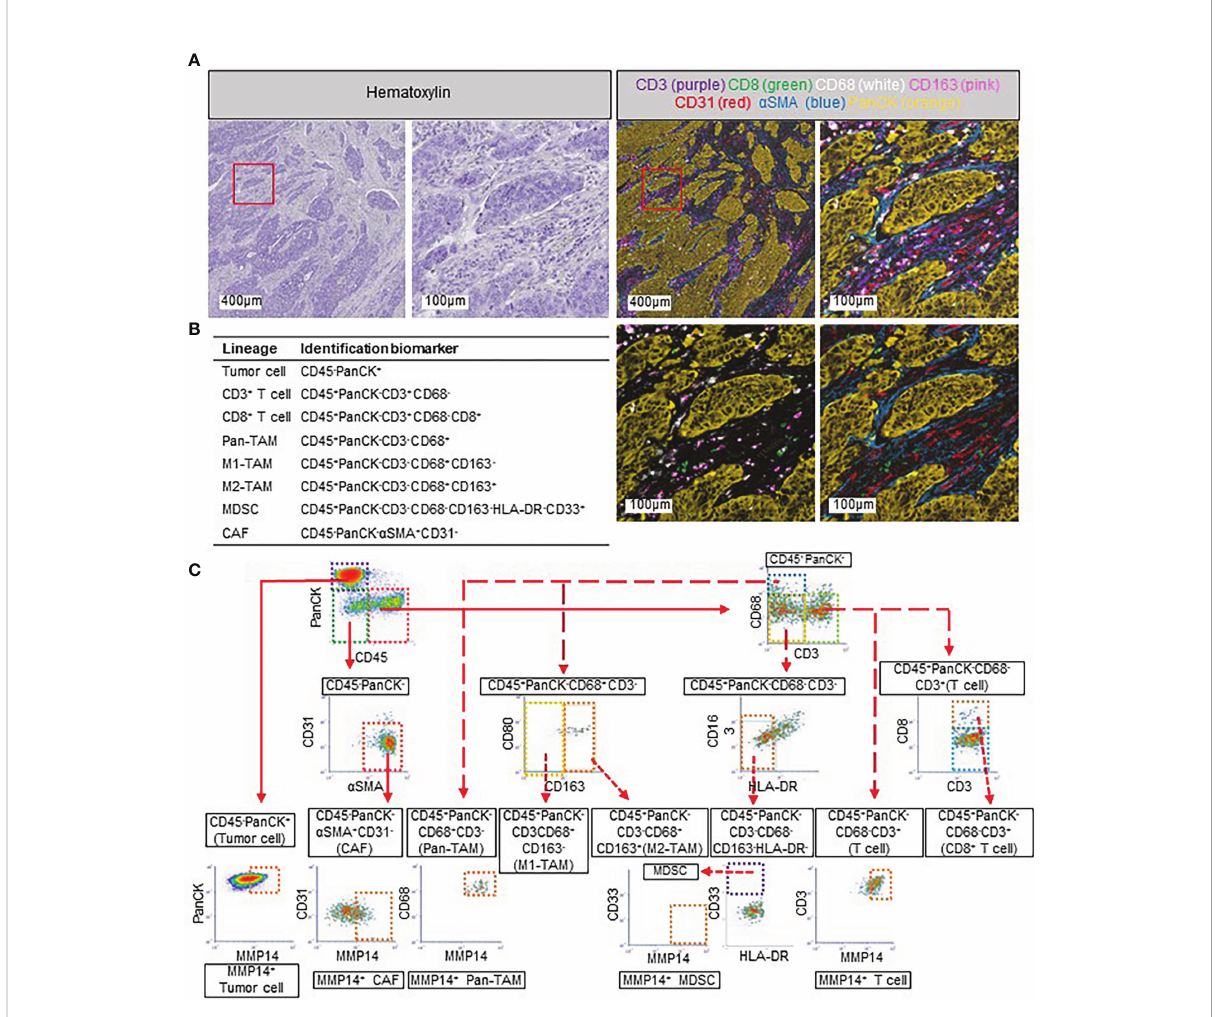
FIGURE 2 Multiplex immunohistochemistry (mIHC) and strategy for quantitative evaluation of cell populations. (A) Representative images of mIHC. Images for hematoxylin staining (upper) and multicolor images (lower) are shown. The area within the red box is shown at higher magni fi cation in the other corresponding images. Seven markers are shown in the top two multicolor images, with CD8 (green), CD68 (white), CD163 (pink), and pan-cytokeratin (panCK, orange) being shown in the lower left image and CD8 (green), CD31 (red), a SMA (blue), and panCK (orange) in the lower right. (B) De fi nition of cell lineages according to marker expression in the present study. (C) Gating strategy for mIHC-based single-cell population